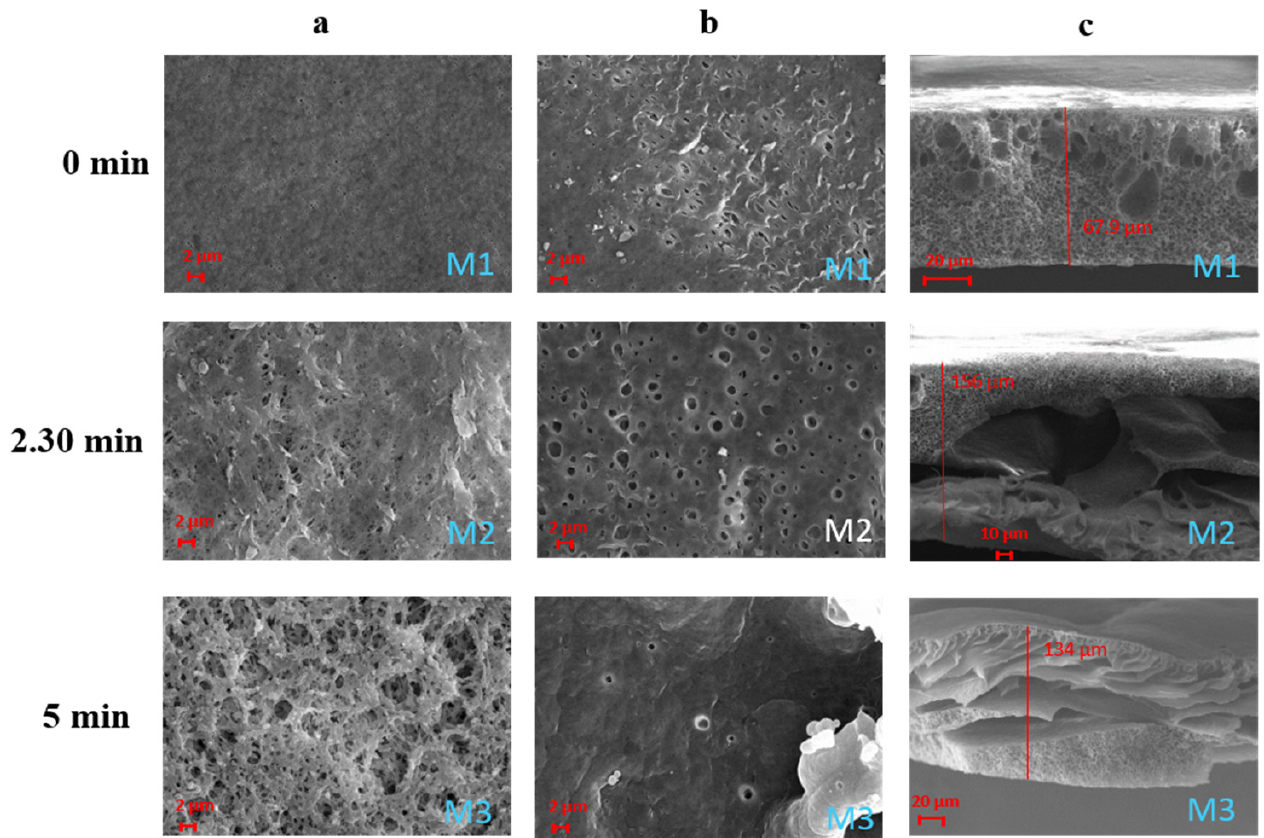
Figure 2. SEM images illustrating the effect of the exposure time to humidity on PVDF-HFP/NMP membranes M1–M3: ( a ) top surfaces; ( b ) bottom surfaces; ( c ) cross-sections.